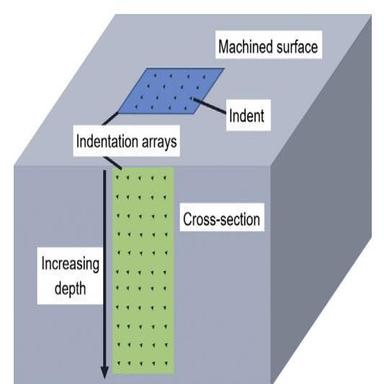
A schematic outlining the location of the nanoindentation measurements.